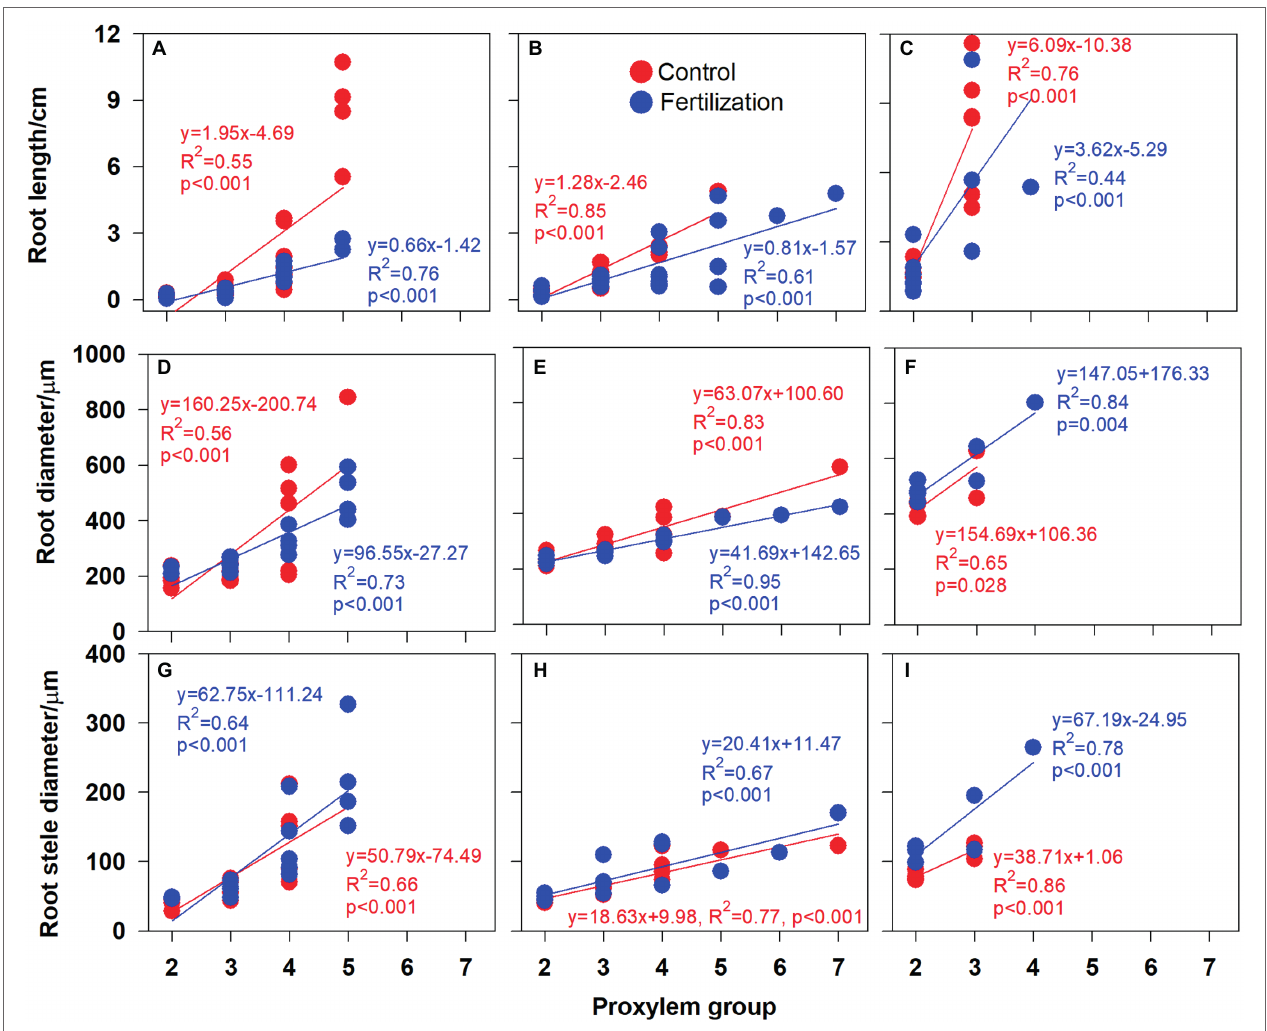
FIGURE 6 | Relationship between the root protoxylem groups number and root length, root diameter and root stele diameter in Juglans mandshurica (A,D,G) , Fraxinus mandshurica (B,E,H) and Phellodendron amurense (C,F,I) ,